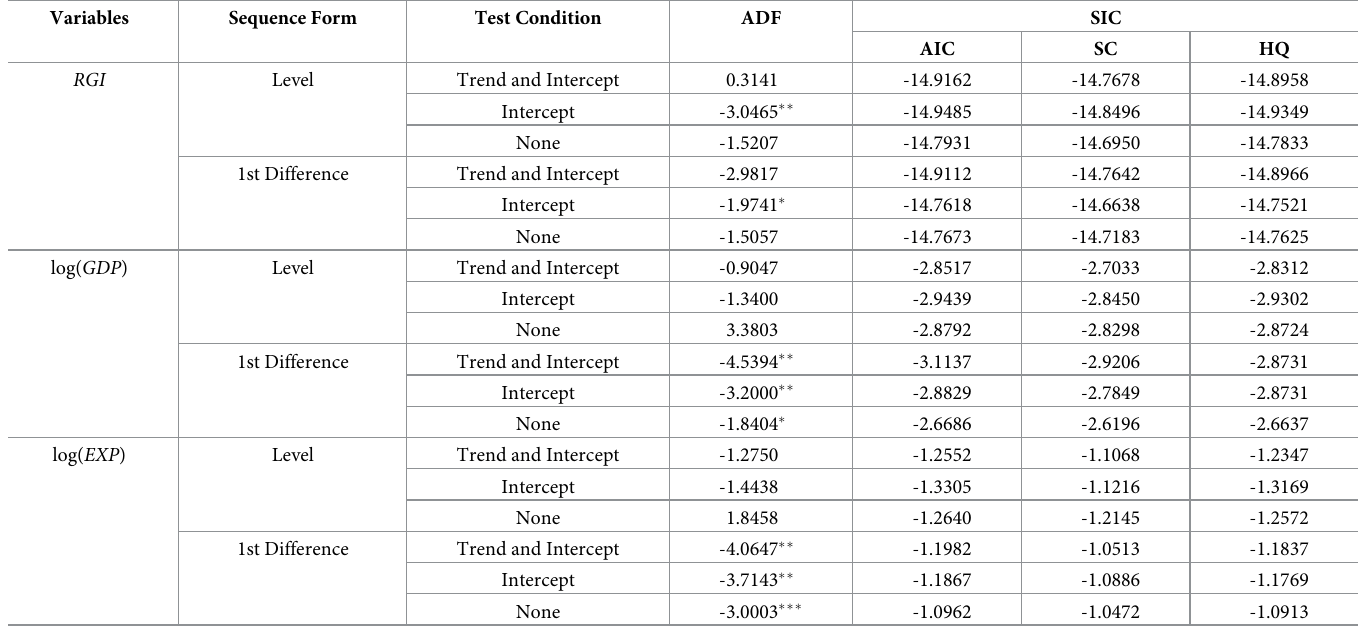
Table 3. Unit root test results of the time series data